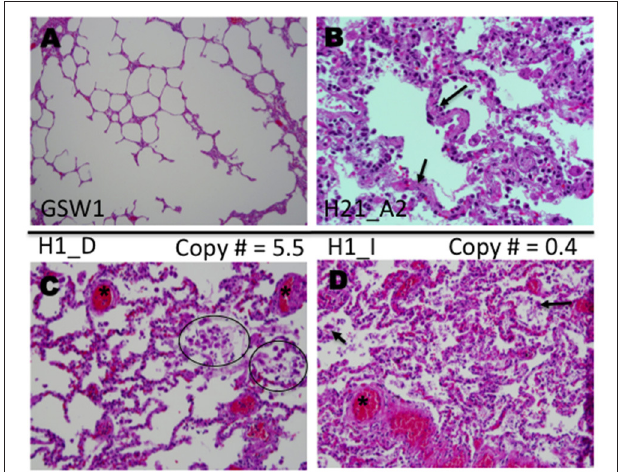
FIGURE 5 | Histological analysis of lung samples of autopsied HPCS cases. Shown are representative sections of lungs stained with Hematoxylin and Eosin (H&E). (A) Sample of lung parenchyma of a gunshot wound decedent, showing open alveolar space (case GSW1). (B) Lung sample of an HCPS patient (case H21 Block A2) highlighting hyaline alveolar membranes (arrows), infiltrates of various immune cells immunoblasts, macrophages and neutrophils (few) (original magnification × 400). (C) Lung sample (case H1 Block D), highlighting focal deposits of macrophages (circles) and intraalveolar extravasated red blood cells (asterisk). (D) Lung sample (H1 case Block I) highlighting extensive congestion and intraalveolar edema with mild interstitial inflammation compared to (case H1 Block D) shown in (C) . The values of 5.5 and 0.4 in (C , D) respectively refer to P2Y 2 R RNA measured in the TaqMan assay (original magnifications for C,D × 200).